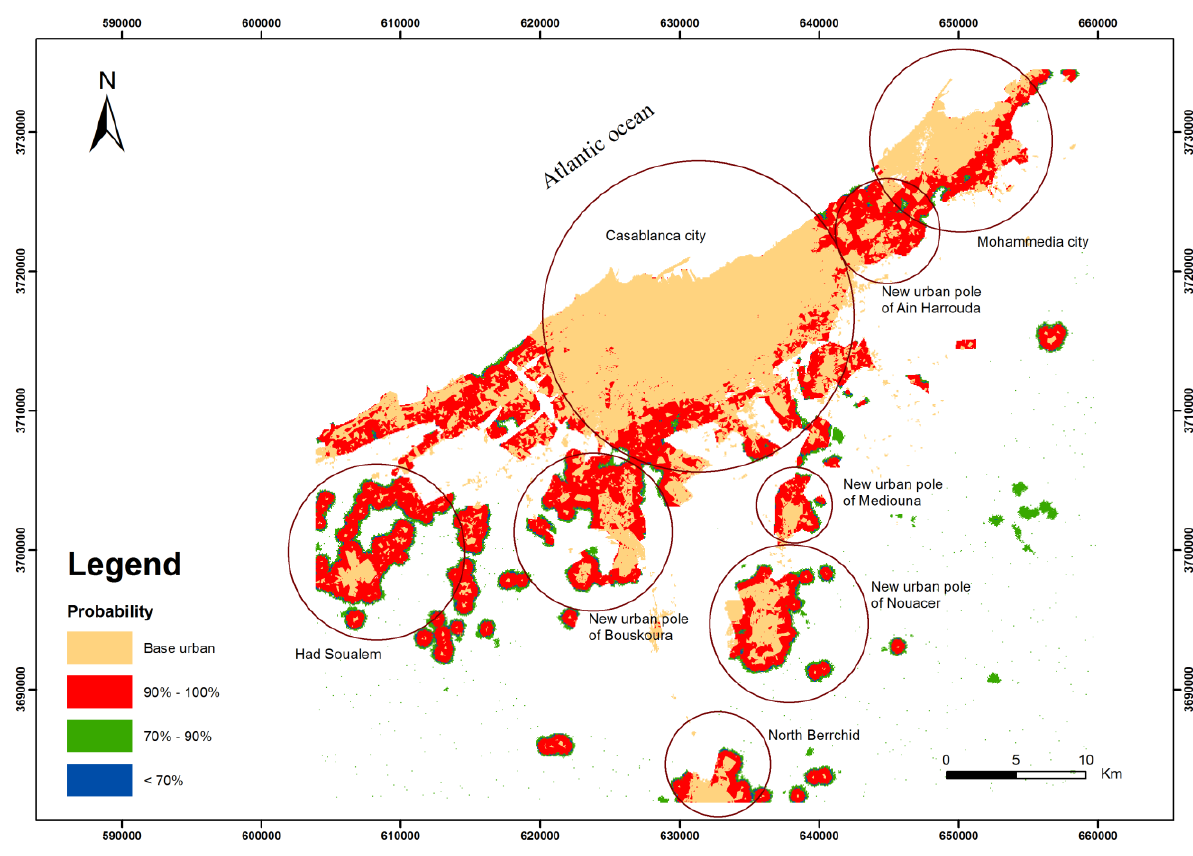
Figure 5. Simulated urban growth map of